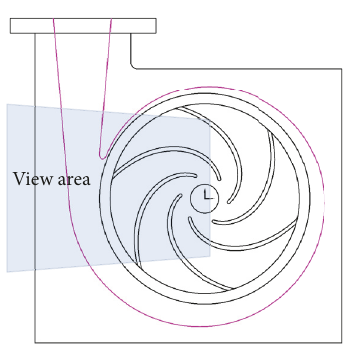
Figure 4: View area of optical measurement of the model pump.